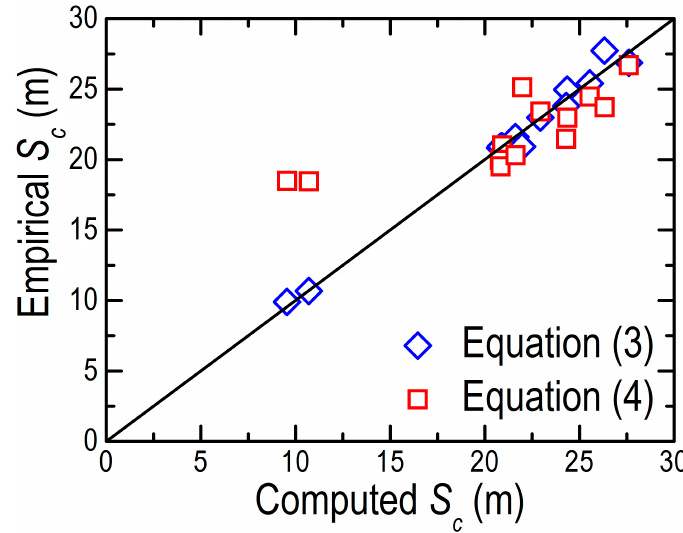
Figure 11. Comparison of the empirical formula and computational fluid dynamics (CFD) results on S c.